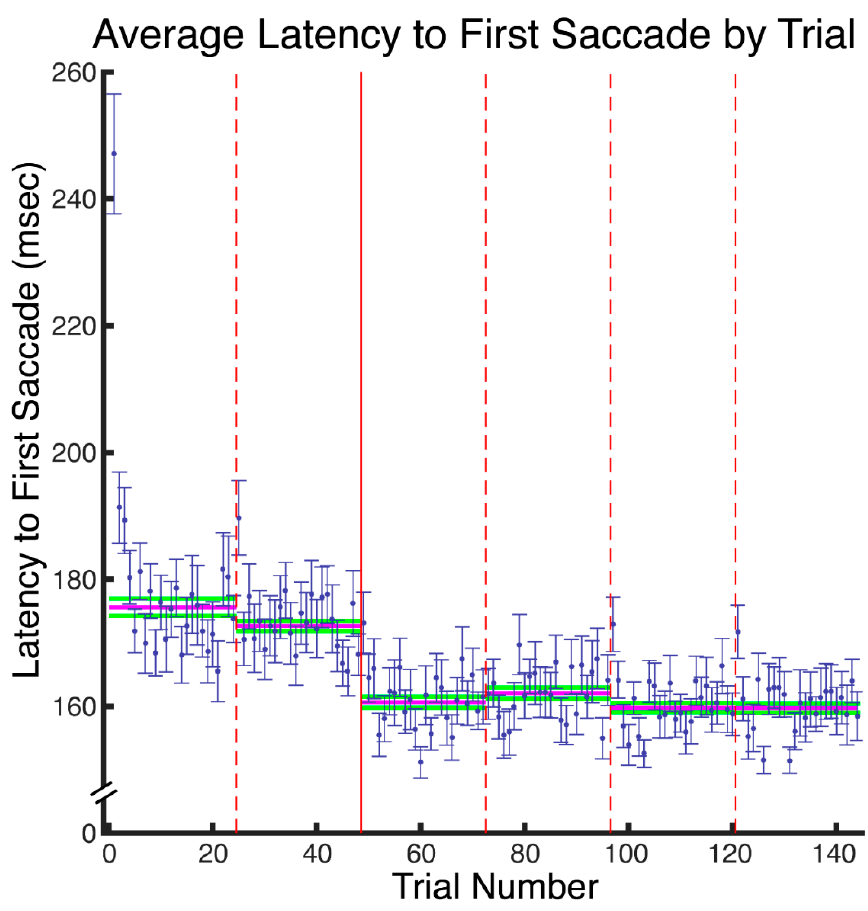
Figure 5. Latency to first saccade by trial into experiment. The average of the participants’ median latencies to first saccade are plotted as a function of trial number. The blue error bars indicate standard errors of the mean. Vertical red lines delineate the blocks of the experiment and the solid red line specifically delineates the study and test phases of the experiment. Magenta horizontal lines indicate the block means of these average trial latencies and the green horizontal lines indicate their respective standard errors. Because the first trial of each block tended to exhibit much longer latencies than other trials, probably related to needing to become engaged with the task, the first trial of each block was excluded from the block averages. This analysis indicates that latencies to first saccade did not gradually become shorter as a function of the number of trials into the experiment, rather there was a clear step-wise shortening of latencies from the study phase to the test phase of the experiment.